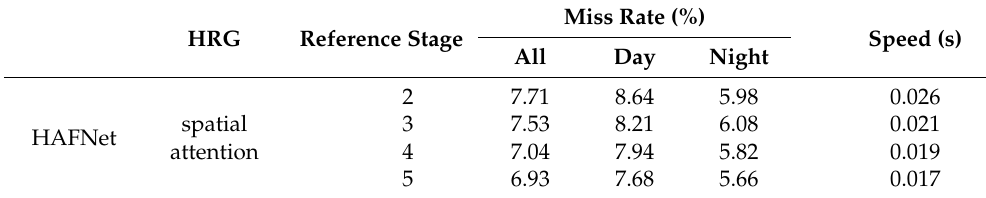
Table 7. Ablation on the Stage to generate the reference feature map.